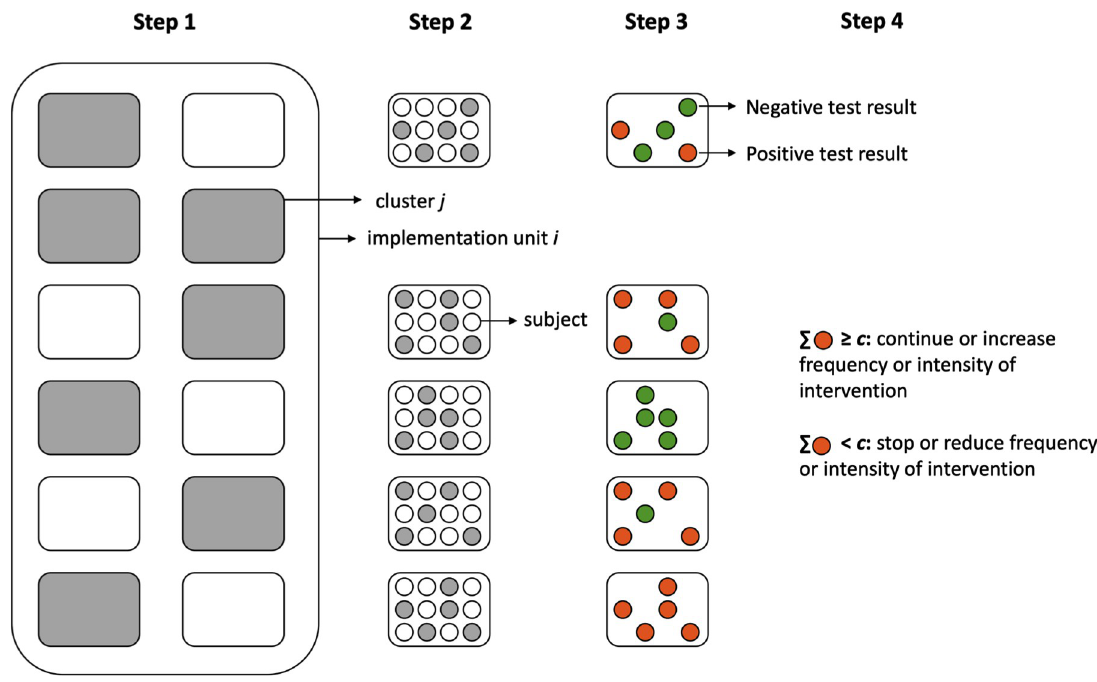
Fig 1. The different steps within the 2-stage LQAS framework for population-based decision-making using an imperfect test.